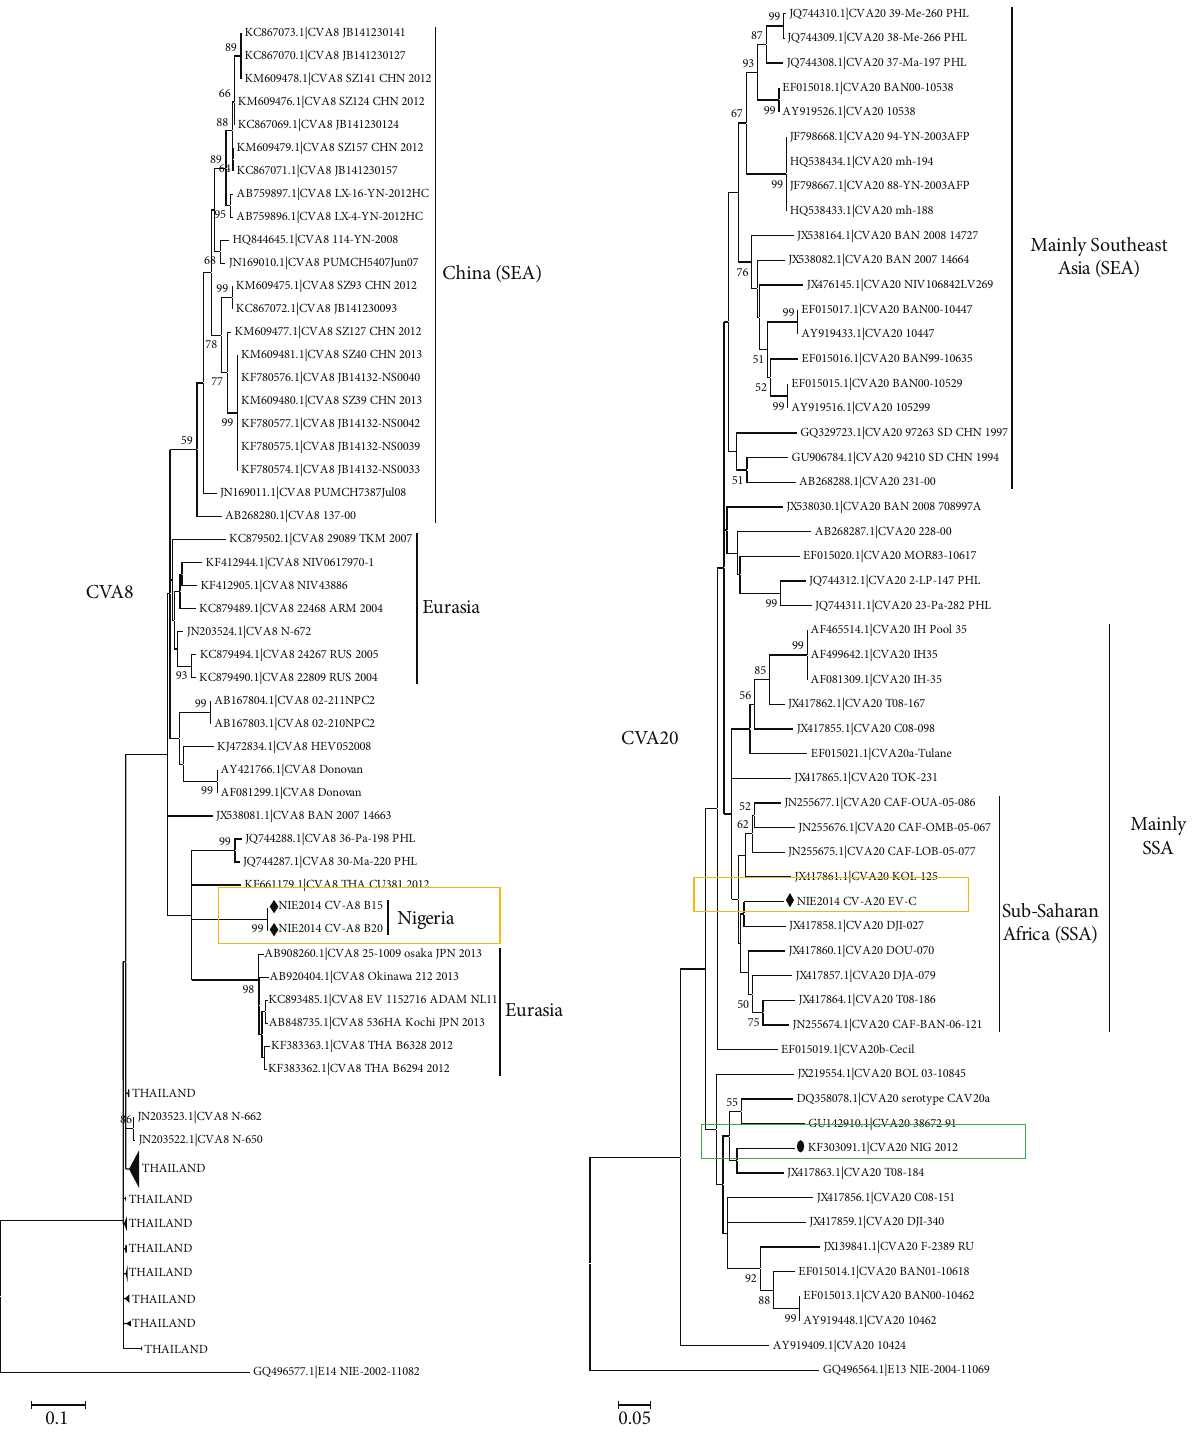
Figure 2: Phylogenetic relationship of recovered CVA8 (a) and CVA20 (b) strains. The phylogram is based on alignment of the partial VP1 sequences. The newly sequenced strains and previous strains from the region are highlighted with black triangles or diamonds and circles, respectively. The GenBank accession number of the strains is indicated in the phylogram. Bootstrap values are indicated if >